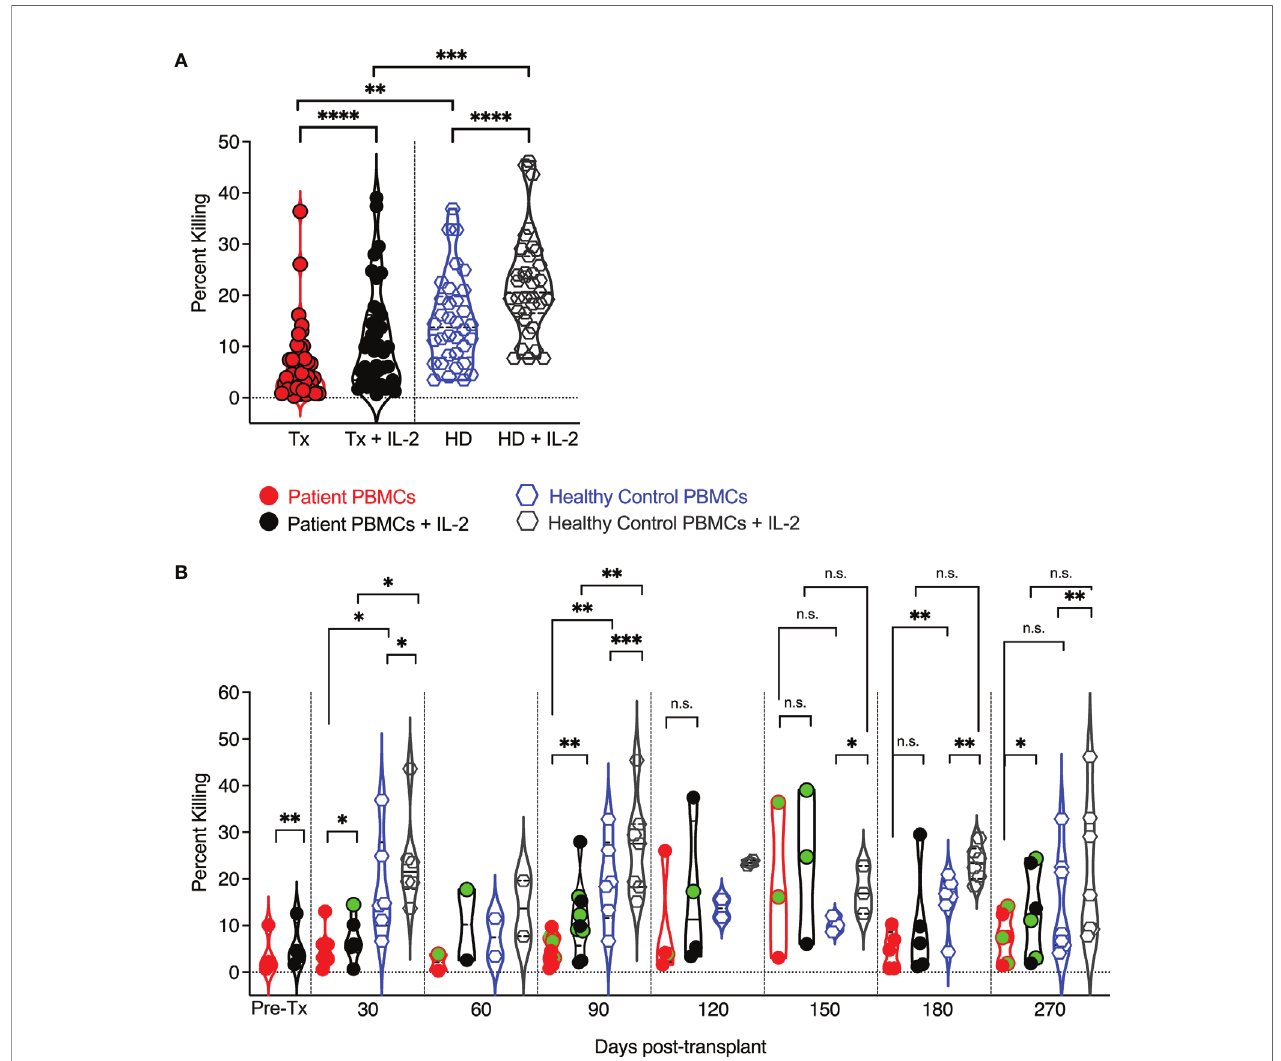
FIGURE 6 | Cytolytic potential of pediatric transplant patients and IL-2 responsiveness vs. human adult donor NK cells. PBMCs were added to (51) Cr labeled K562 target cell at an effector to target ratio of 25:1. After four hours of co-incubation, supernatants were harvested and counted in a gamma counter to assess (51)Cr release as a measure of target lysis. At each time point, circulating healthy adult control donor NK cells were also analyzed. Each data point represents a single transplant recipient or healthy adult control donor (HC). Data points with a neon-green fi ll color represent patients positive for CMV up to and at the analysis time as determined by quantitate PCR. (A) Pooled analysis of all time points and comparison of adult patient and healthy adult donor NK cell cytotoxic capabilities. (B) Cytolytic potential of pediatric transplant patients vs. human adult donor NK cells and IL-2responsiveness at each examined time point post-transplant and in comparison to healthy adult control NK cells assessed at each time point. *p < 0.05; **p < 0.005; ***p < 0.0005; ****p < 0.0005; Not signi fi cant